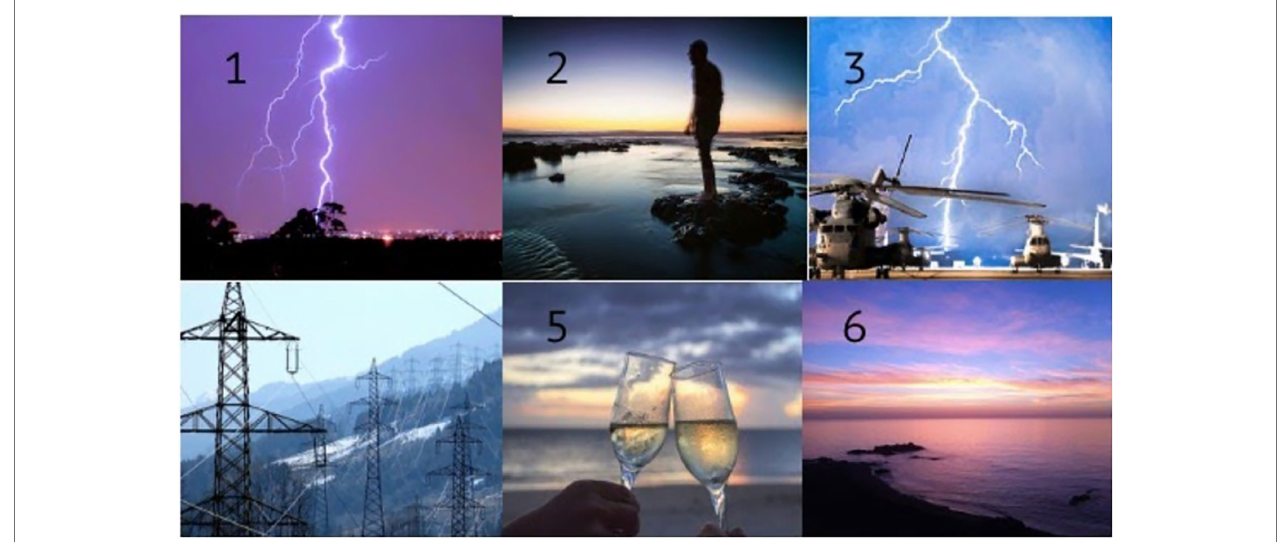
FIGURE 3 | Banner stimuli presented for recognition (Marsden et al., 2018). Images available at https://www.oasis-database.org.